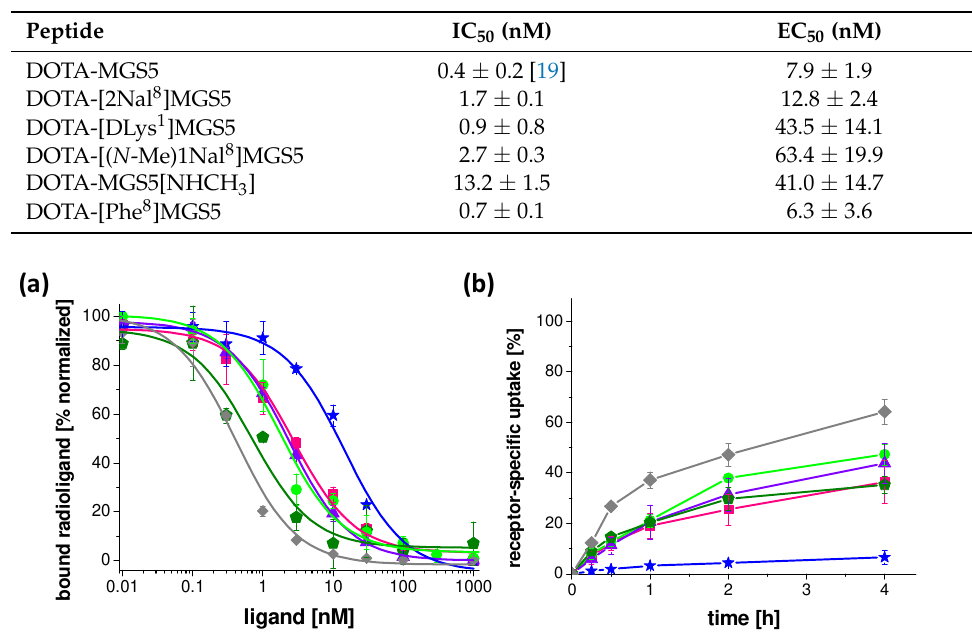
Figure 2. Receptor interaction on A431-CCK2R cells: ( a ) binding curves obtained for the unlabeled peptide derivates from competition assays with [ 125 I][3-iodo-Tyr 12 ,Leu 15 ]gastrin-I; ( b ) Cell internal- ization of the different 111 In-labeled peptide derivatives. Gray: previously studied DOTA-MGS5 [19], pink: DOTA-[2Nal 8 ]MGS5, green: DOTA-[DLys 1 ]MGS5, purple: DOTA-[(N-Me)1Nal 8 ]MGS5, blue: DOTA-MGS5[NHCH3], olive: DOTA-[Phe 8 ]MGS5.